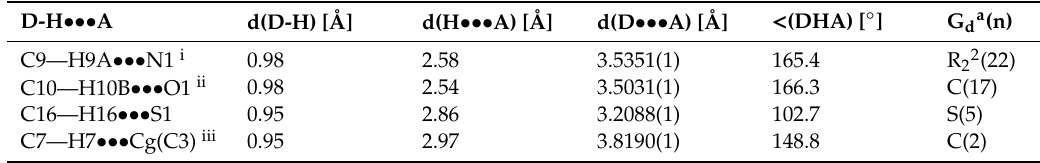
Table 3 . Non-classic hydrogen bonds and the first level graph motifs in the studied compound. Cg(C3) indicates centroid of ring containing C3 atom.